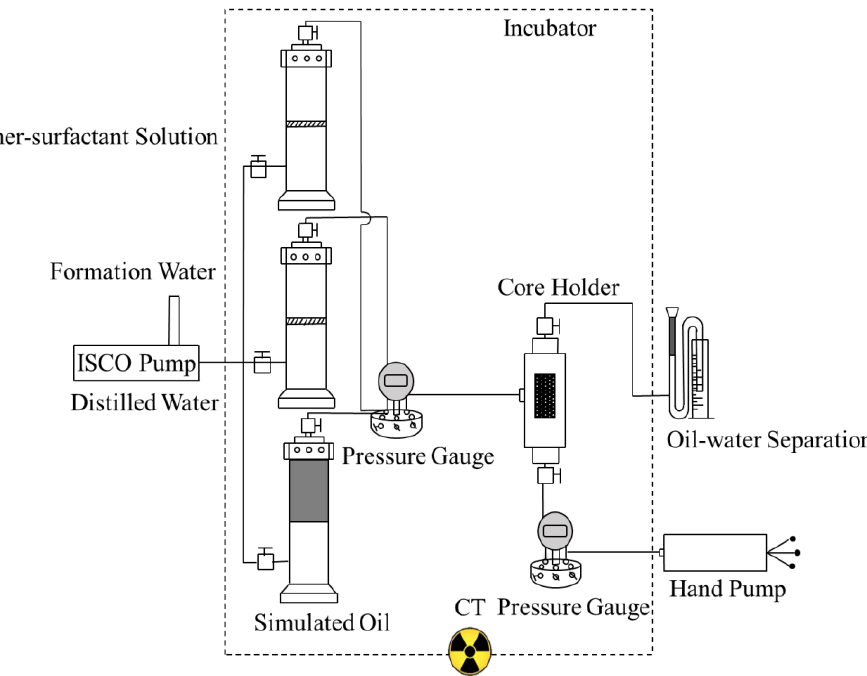
Figure 1. X-ray micro-focus CT imaging experimental